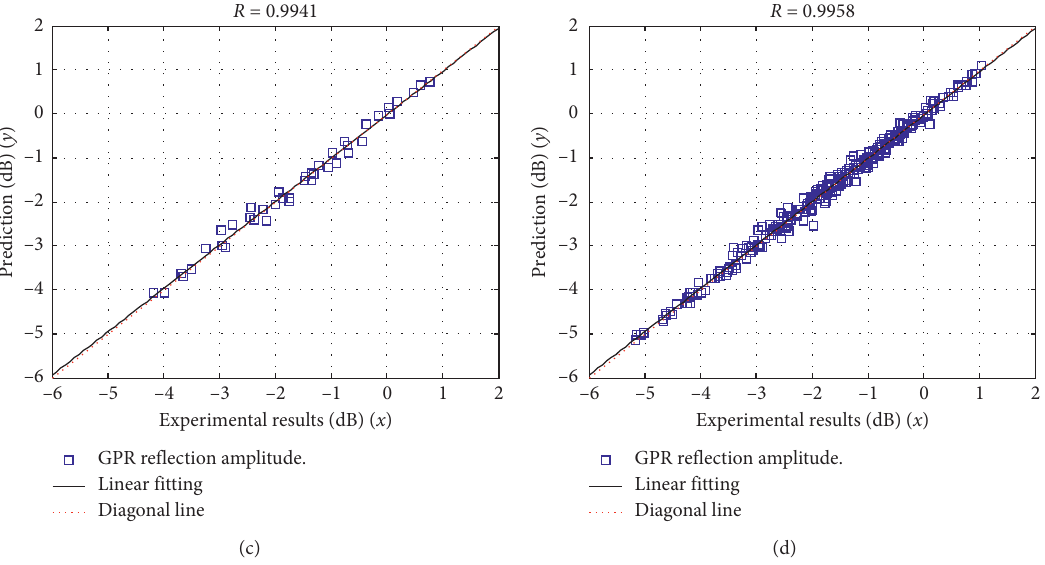
Figure 6: Performance of selected ANN model. (a) Training. (b) Validation. (c) Testing. (d) Overall.